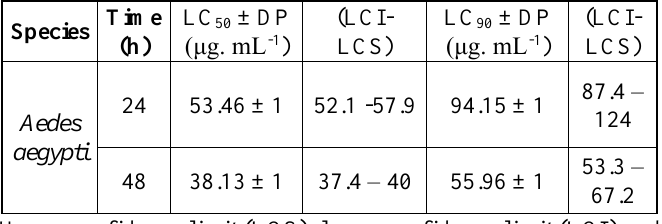
Table 1. Values of LC 50 (inhibitory concentration) and CL 90 (lethal concentration) of the essential oil of Piper callosum in natura against Aedes aegypti